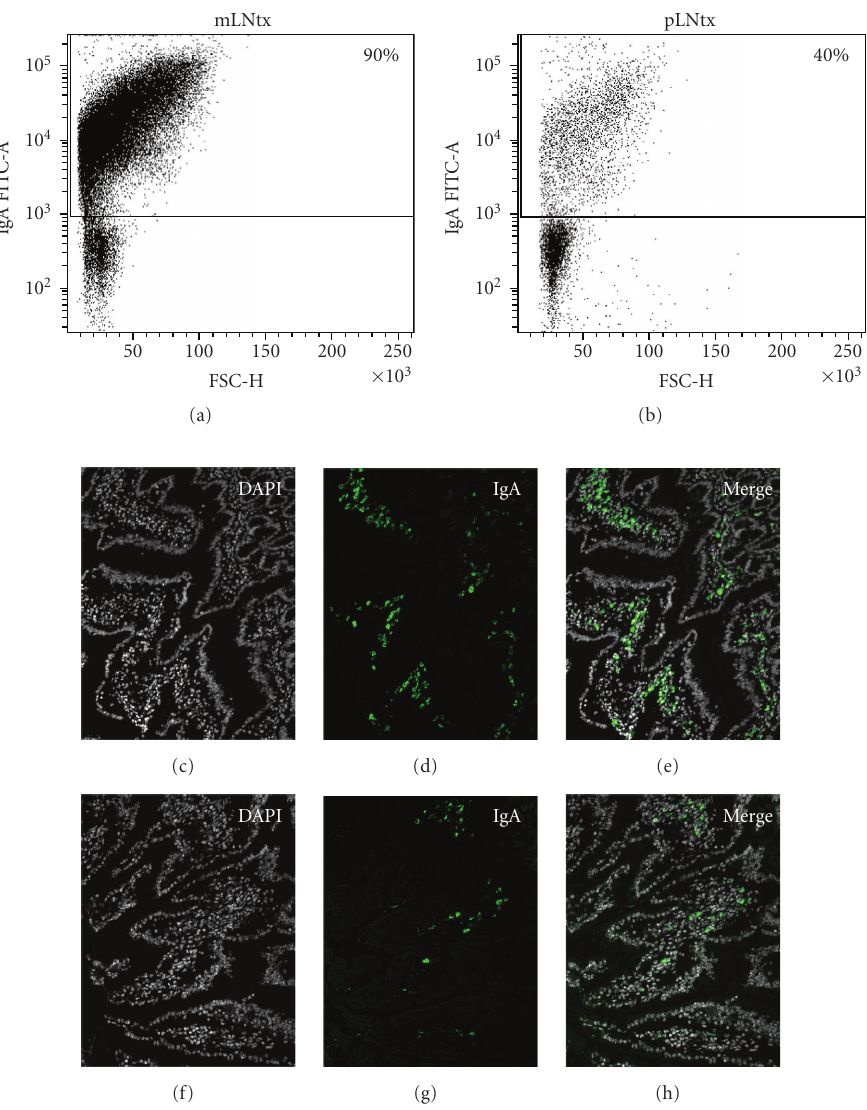
Figure 3: The number of immunoglobulin A (IgA) + cells in the lamina propria is decreased after transplantion of pLN into the mesentery. The gut of mLNtx and pLNtx transplanted animals was analyzed by gating on IgA + cells by flow cytometry. Dot plots of the IgA + cells of mLNtx and pLNtx are shown. Furthermore, immunofluorescence staining of the lamina propria of the gut in mLN transplanted and pLN transplanted rats was carried out with antibodies against IgA (green). Dapi was used to visualize all cells. IgA + cells were seen in both groups, but to a lesser extent in pLNtx